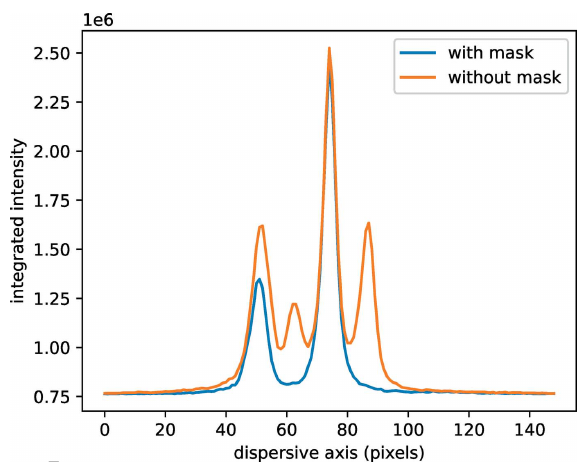
Figure 7 Horizontal cut of Fig. 6 at 13 mm on the ordinate (orange curve). Blue data show the same acquisition with masking a 1 mm-wide segment of the crystal at its edge with a Pb